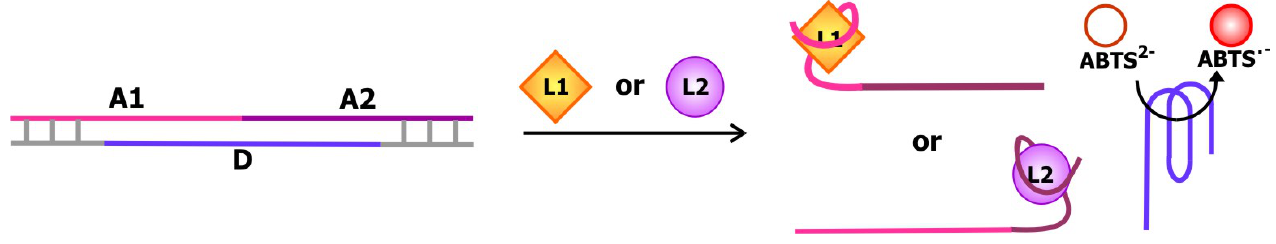
Figure 13. A structure-switching biosensing system comprised of the bifunctional aptamer that can bind either ligands L1 or L2 and a deoxyribozyme with horseradish peroxidase- like activity (D) [75]. The binding of either L1 or L2 results in the liberation of the deoxyribozyme, allowing it to oxidize ABTS 2- to produce the red-coloured ABTS -